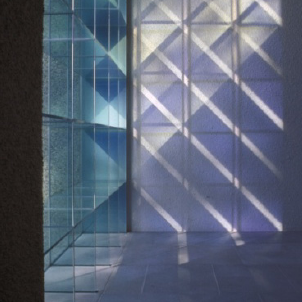
Figure 12: view of the depth of the structural glass wall. This depth matches the depth of the chapel’s